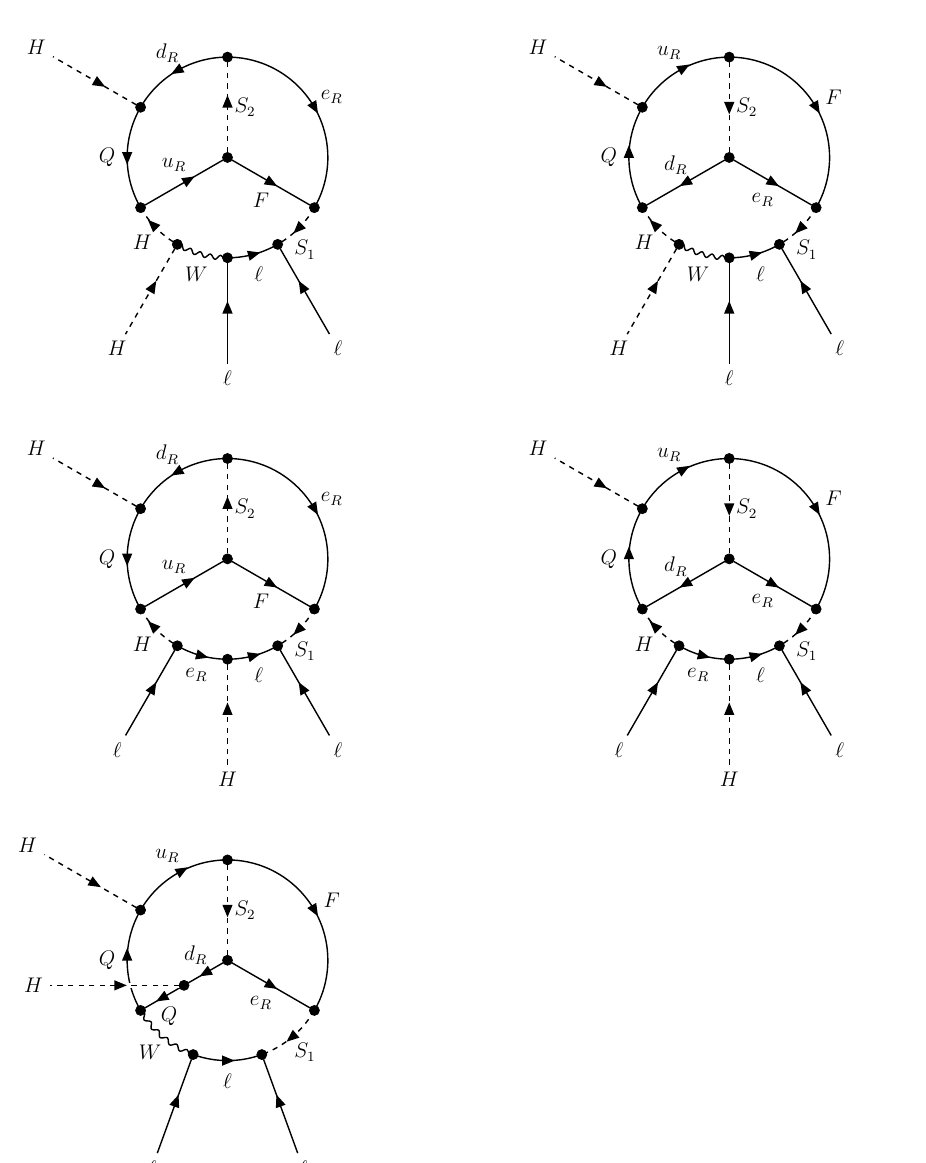
Figure 16 . The diagrams for the neutrino masses in the example model NL3-1-3-2-7-1-4 of long- range 0 νββ decay, for which the diagonal entries of the neutrino mass matrix is vanishing. Notice that the inner loops can not be compressed to tree-level renormalizable vertices due to the antisymmetric nature of some SU(2) contractions and the chiral structure of the L